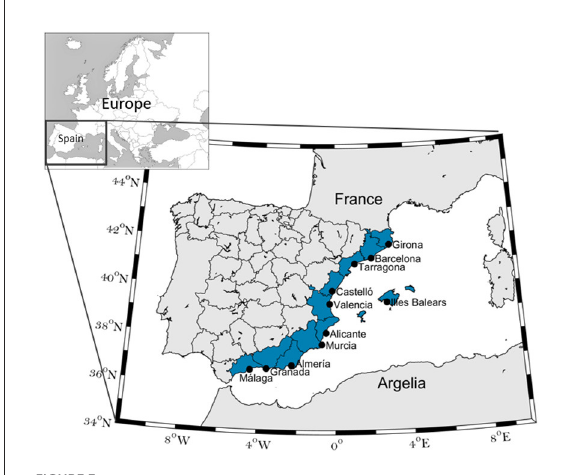
FIGURE3 Study site with the provinces included in the study (blue area) and the main cities (black